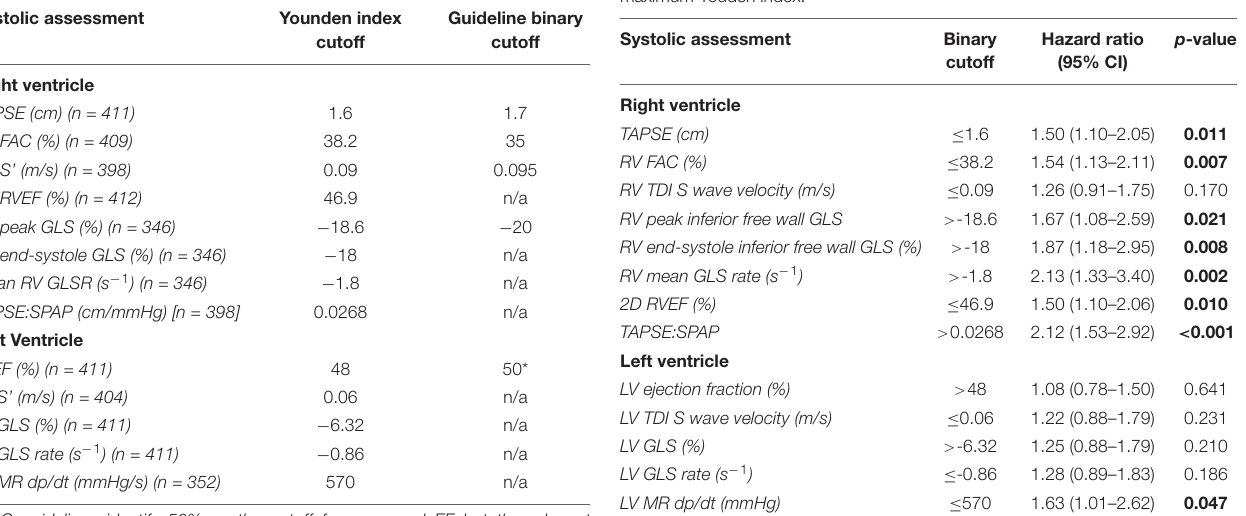
TABLE 2 | Assessments of right ventricular (RV) and left ventricular (LV) systolic dysfunction with binary cutoffs as determined by the criteria associated with the maximum Youden